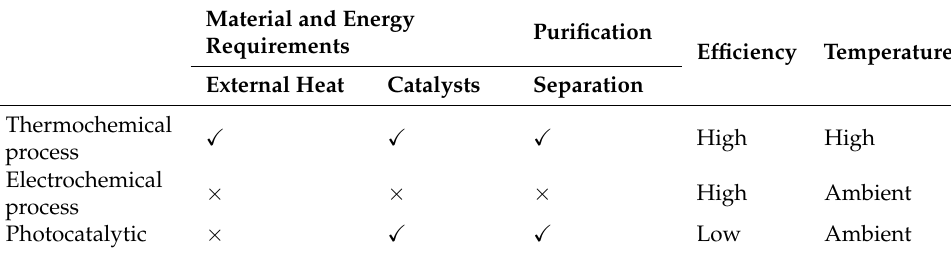
Table 14. Comparison of various ammonia decomposition methods for hydrogen production. Material and Energy